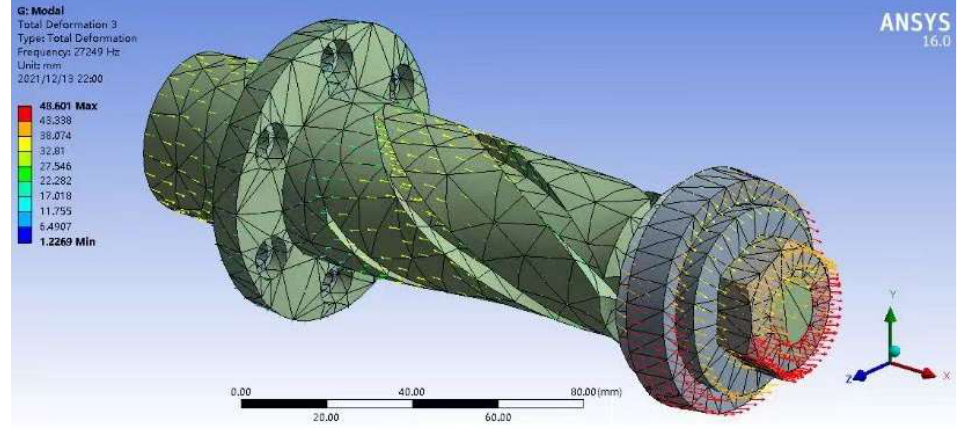
Figure 6. Finite element simulation analysis of horn vibration.